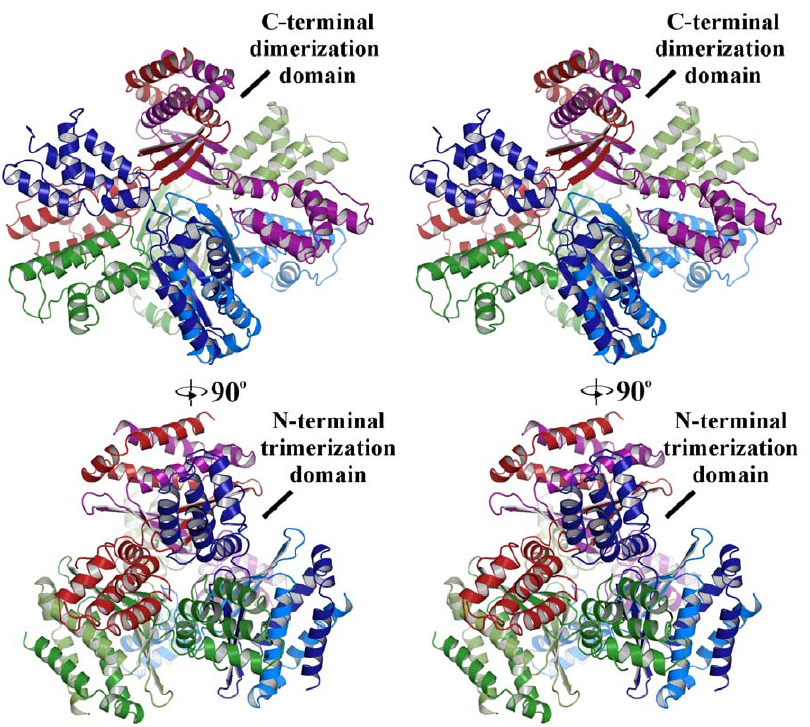
Figure 4. Stereo image of a predicted Cpn0803 hexamer colored by chain. We evaluated Cpn0803 for its ability to form multimers by analysis with the PISA server. Based on crystal contacts and buried surface area, the biologically active unit of Cpn0803 was predicted to be a hexamer formed by a trimer of dimers. The individual monomeric units are shown in different colours.